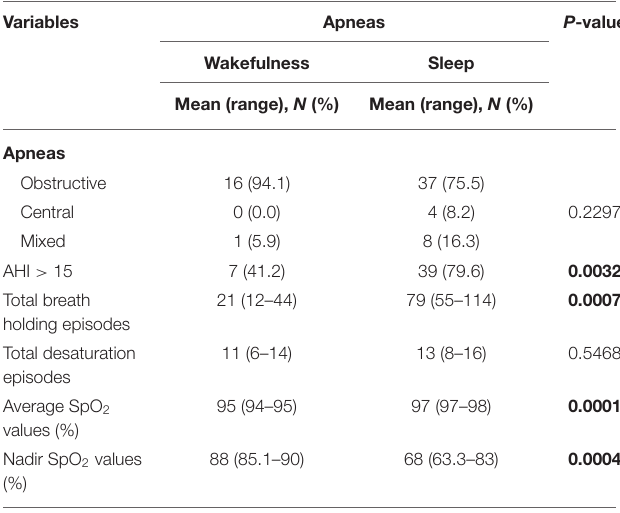
TABLE 6 | Cardiorespiratory monitoring of the examined population with RTT as a function of wakefulness ( n = 17) vs. sleep apneas ( n = 49).